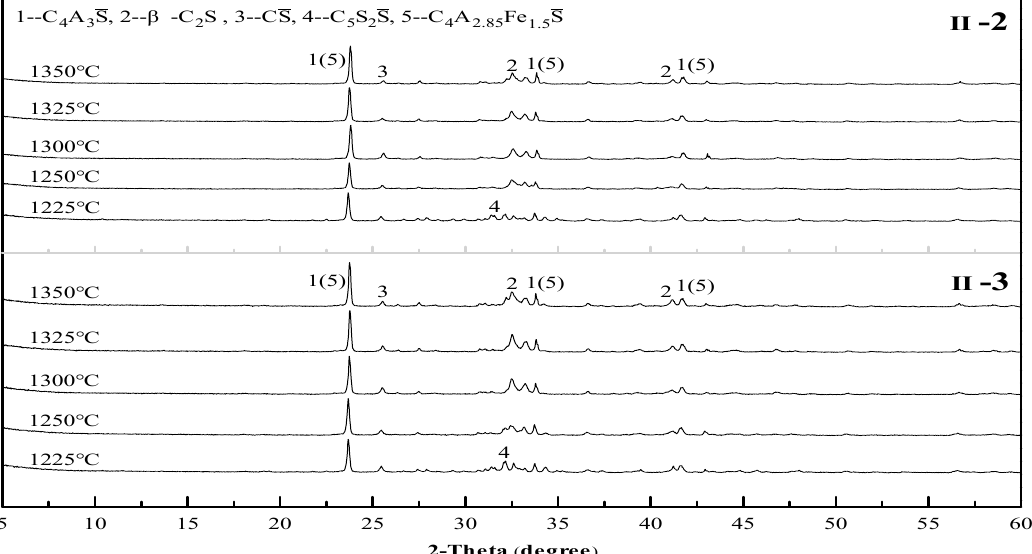
Figure 5. X-ray diffraction (XRD) patterns of the Series I cement clinkers at different temperatures.